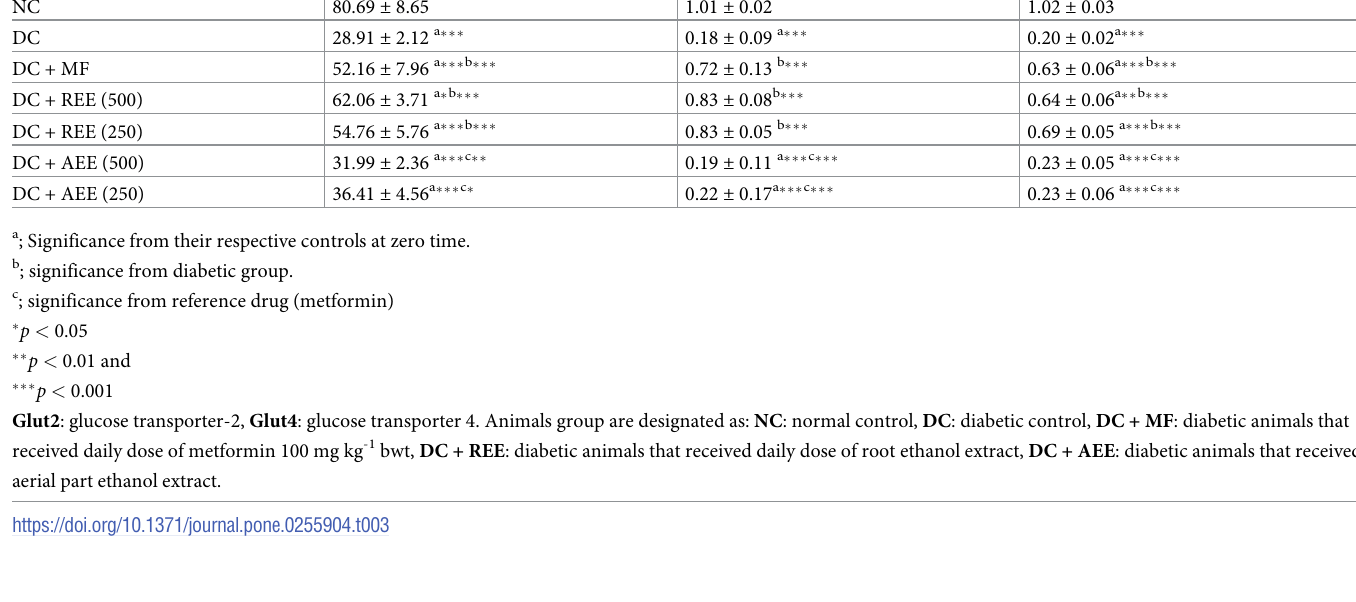
Table 3. Effect of REE and AEE on insulin level and glucose transport in diabetic rats.